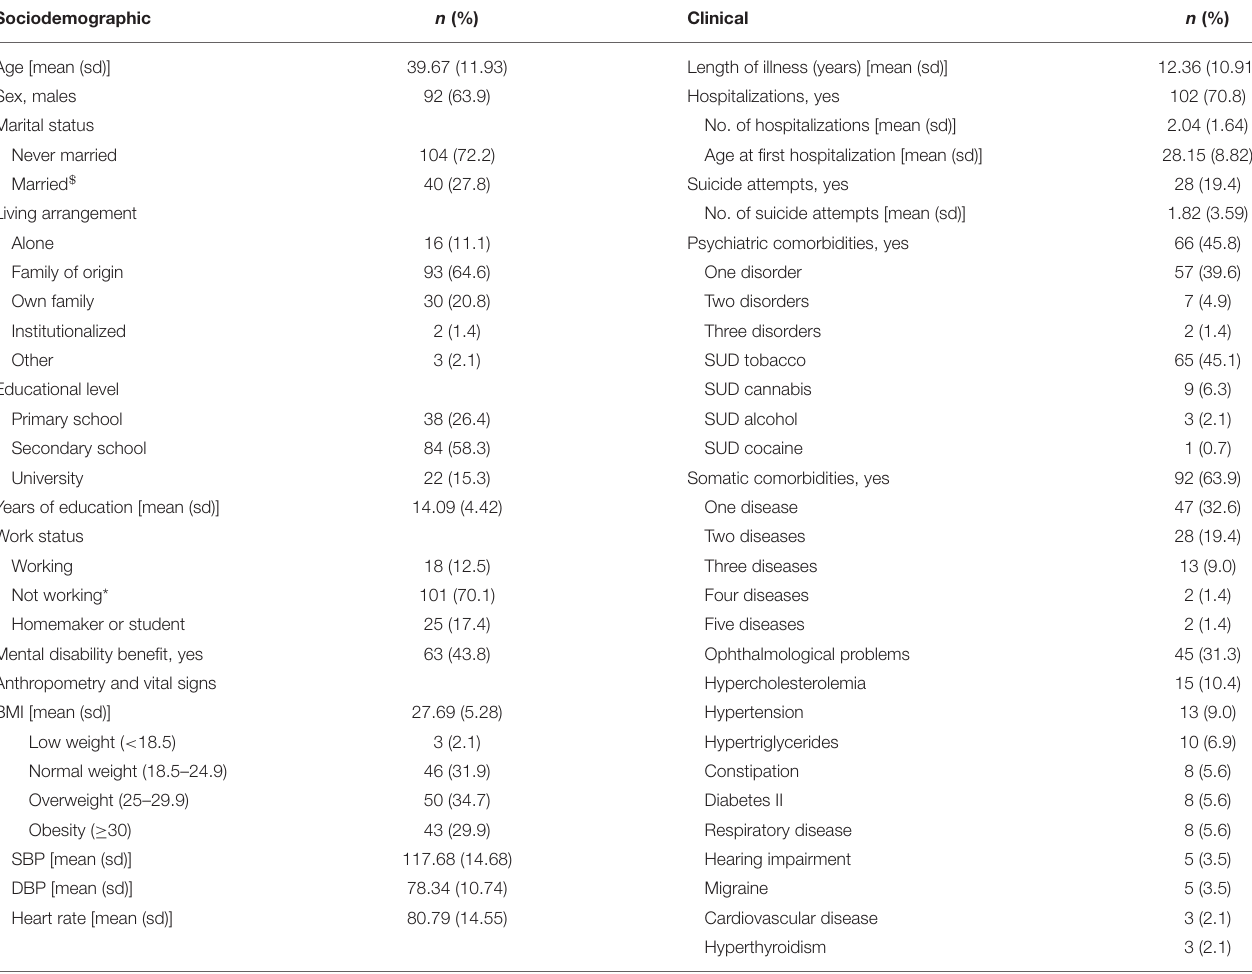
TABLE 1 | Sociodemographic and clinical characteristics of the sample.